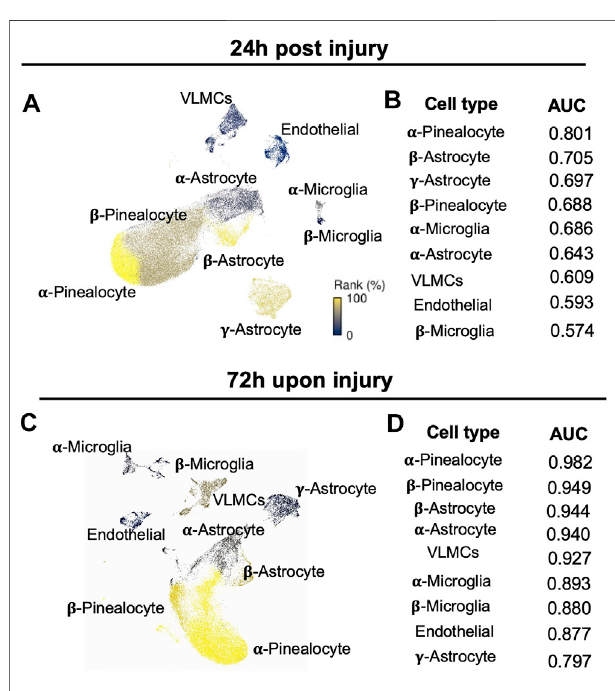
FIGURE 3 | Identi fi cation of cell type prioritization in the pineal gland upon neonatal HIBD (A,C) UMAP visualization of distinct cell types colored by Augur cell type prioritization at 24 h (A) or 72 h (C) post sham or neonatal HIBD, respectively (B,D) Values of the area under the receiver operating characteristic curve (AUC) of distinct cell types colored by Augur cell type prioritization at 24 h (B) or 72 h (D) post sham or neonatal HIBD, respectively.